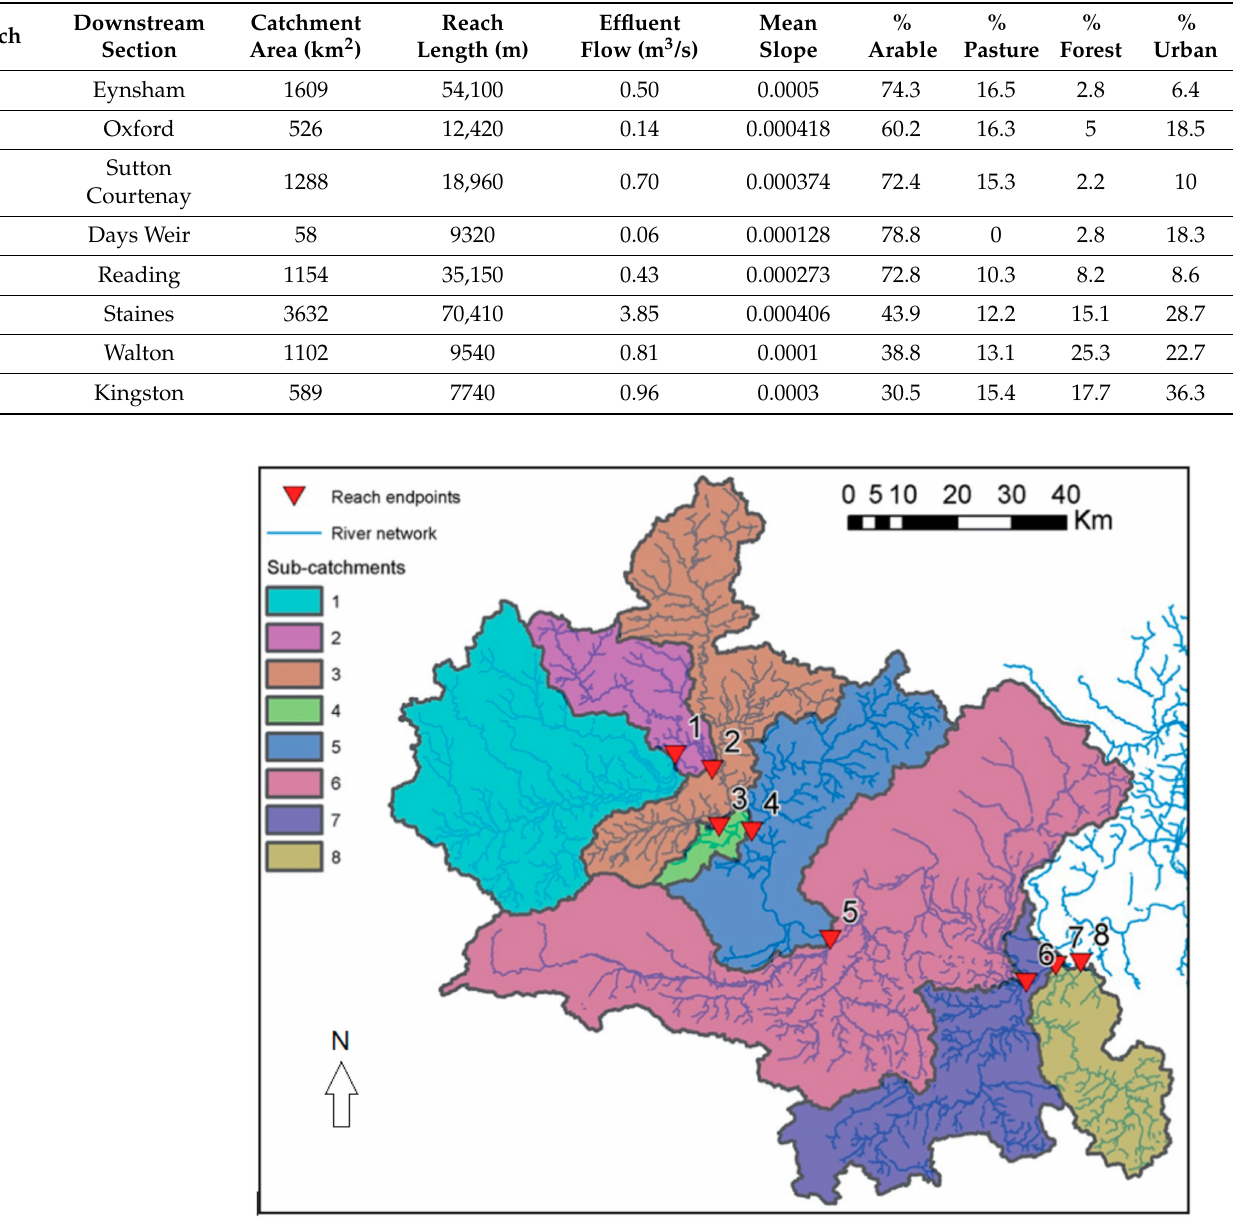
Figure 1. The non-tidal part of the Thames River catchment used in the simulations showing reach endpoints and sub-catchment